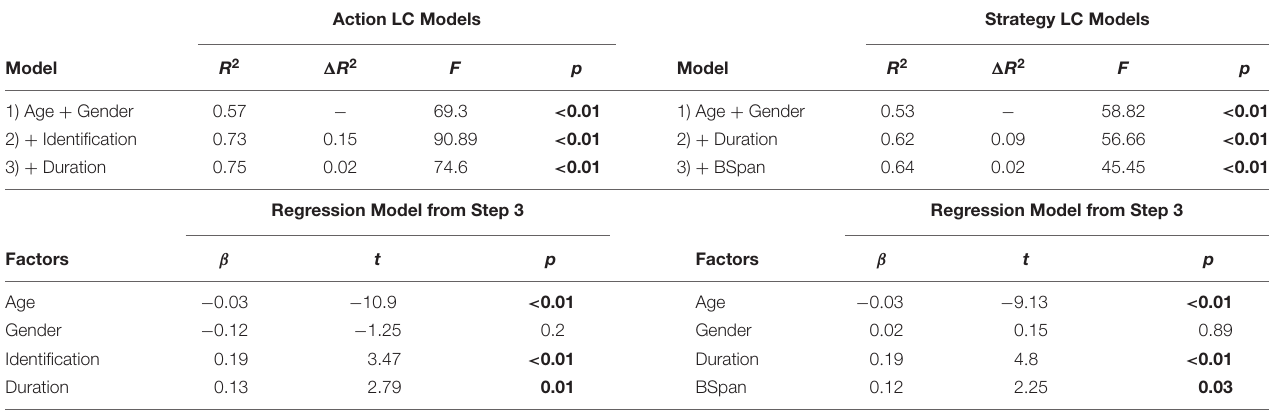
TABLE 3 | Results of stepwise regression across 3 steps.